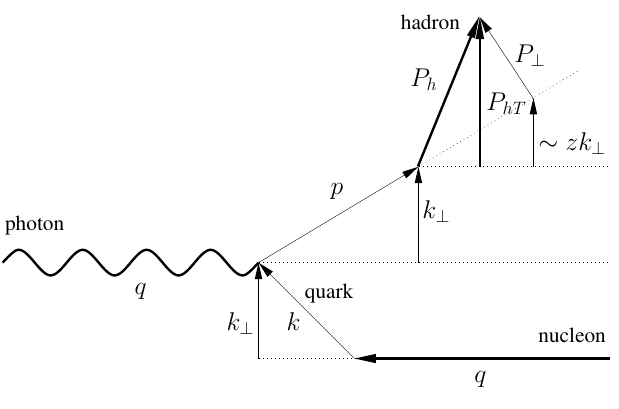
Figure 1 . Diagram describing the relevant momenta involved in a semi-inclusive DIS event (see also ref. [38]): a virtual photon (defining the reference axis) strikes a parton inside a proton. The parton has a transverse momentum k ? (not measured). The struck parton fragments into a hadron, which acquires a further transverse momentum P ? (not measured). The total measured transverse- momentum of the final hadron is P hT . When Q 2 is very large, the longitudinal components are all much larger than the transverse components. In this regime, P hT z k ? + P ? (cid:25)